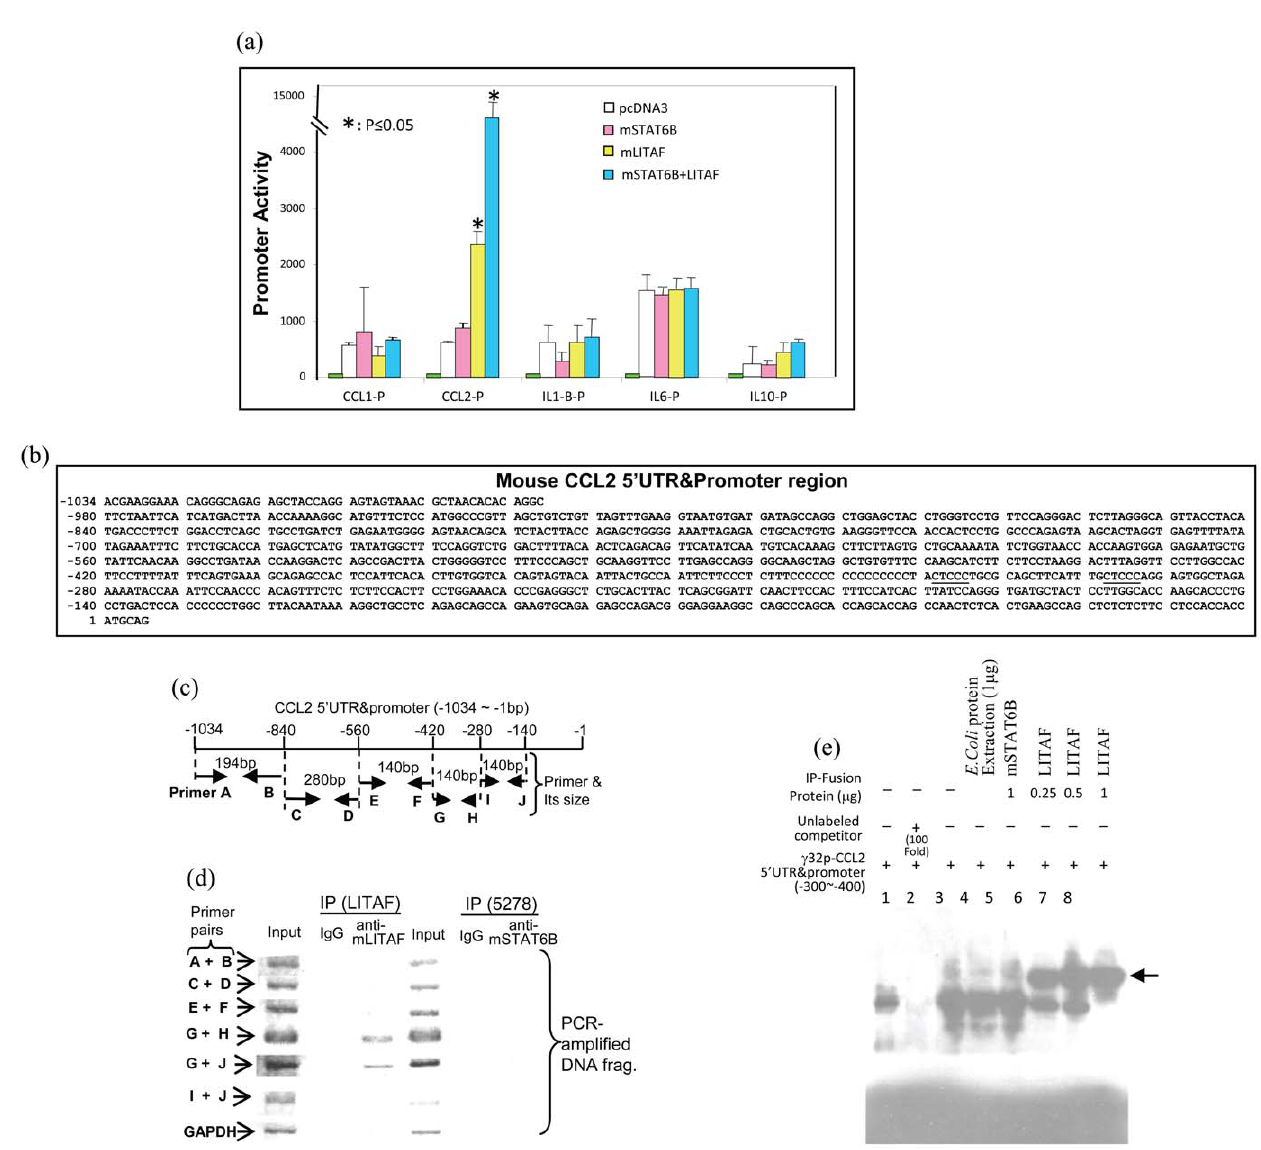
Figure 2. mSTAT6B and/or mLITAF-mediated cytokine promoter activities. (a) Raw264.7 cells were untreated as control (green bars) and transiently transfected with reporter genes of CCL1-p, CCL2-p, IL-1 b -p, IL-6, or IL-10-p with the addition of pcDNA3 (white bars), mSTAT6B (pink bars), mLITAF (yellow bars), or both mSTAT6B and mLITAF (blue bars). All test cells were cotransfected with 5 ng of b -gal DNA. Cell lysate was then purified and examined by luciferase assay. Triplicate assays were performed and their values were normalized to b -gal production and graphed. (b) Diagram of mouse CCL2 5 9 UTR&promoter DNA sequence in the region from 2 1,034 to 1. The putative mLITAF binding site (CTCCC) in the region ( 2 319 , 2 315, 2 298 , 2 294) is underlined. (c) Diagram of primer (A–J) location in mouse CCL2 5 9 UTR&promoter DNA and their size. (d) CHIP assay. DNAs from input group as control or CHIP group (LITAF or 5279) were used for PCR with primer pairs of A&B, C&D, E&F, G&H, G&J, or I&J. The control (input) group showed DNA fragments that were amplified by PCR with all primer pairs. Fragments amplified by PCR with primer pairs G&H or G&J were shown only in the LITAF CHIP group. None of the PCR-amplified DNA fragments in mSTAT6B (5278) CHIP group were observed. The assays were performed in triplicate and a representative experiment is presented. (e) EMSA. HA-immunoprecipitated protein (IP) from each test cells was purified and added to the appropriate reaction buffer with the 32p-ATP-labeled double stranded CCL2 oligonucleotide (GCAGAGCCACTCCATTCA- CACTTGTGGTCACAGTAGTACAAT TACTGCCAATTCTTCCCTCTTTCCCCCCCCCCCCCCCTACTCCCTGCGCAGCTTCATTT) as DNA probe. Treatment with DNA probe alone in No. 1 and 3, with 100-fold excess of unlabeled competitor (No. 2), or plus 1 m g of E. coli extraction as control (No. 4), 1 m g IP- mSTAT6B (No. 5), different concentration of IP-mLITAF (0.25 m g in No. 6, 0.5 m g in No. 7, 1 m g in No. 8) were assessed by EMSA. The shifted bands are indicated by arrow. The assays were performed in triplicate and a representative experiment is presented.